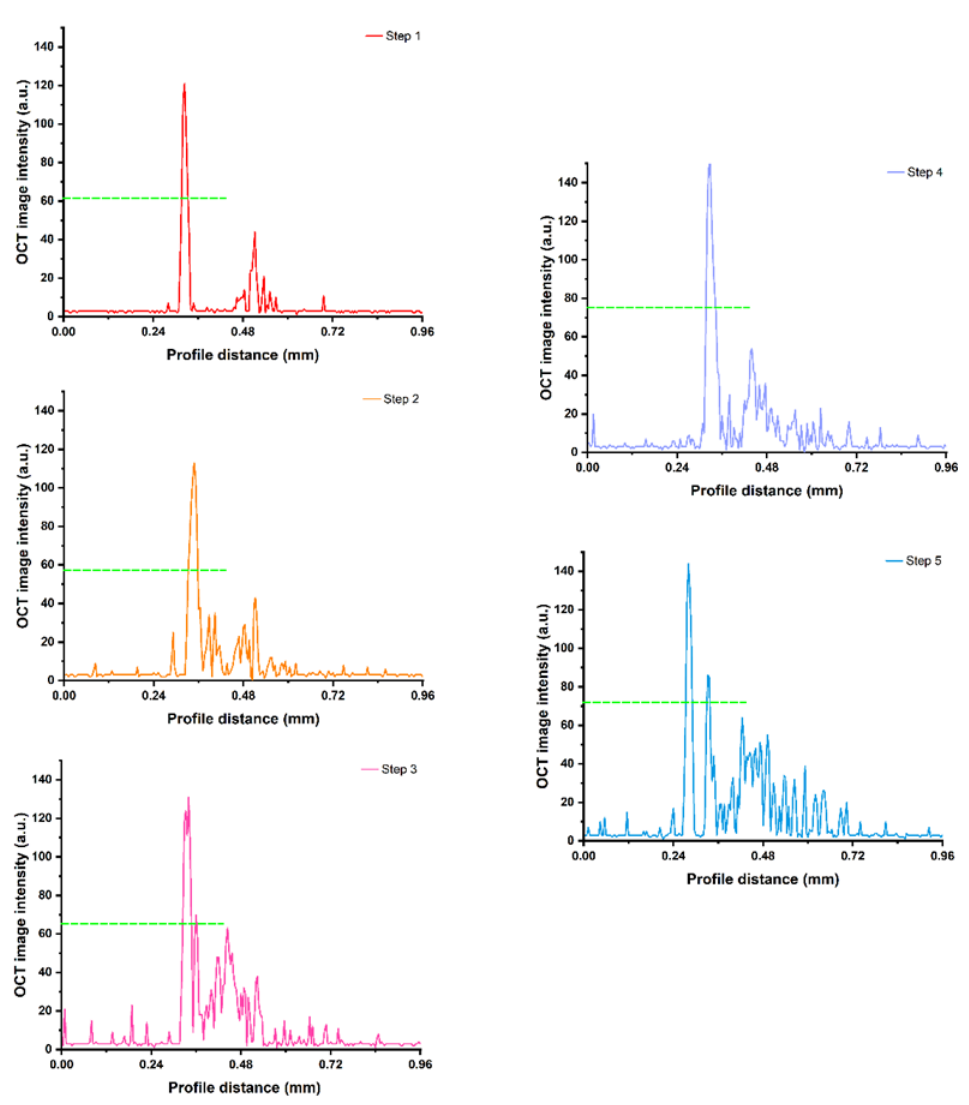
Figure 3. The OCT image intensity with profile distance in Steps 1, 2, 3, 4 and 5. Dashed line: the half maximum of each step. The half maximum OCT image intensity in Step 4 was the maximum, followed by Step 5, Step 3, Step 1, and Step 2.